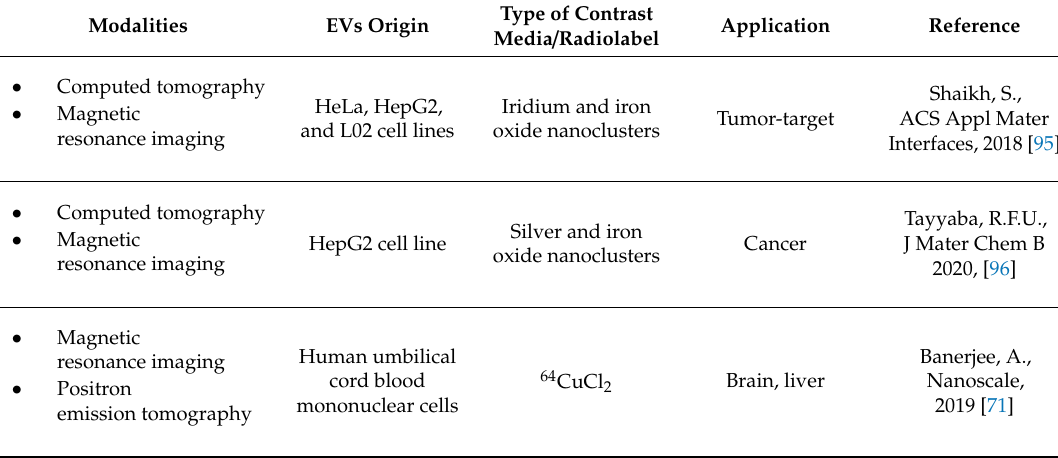
Table 3. Studies on multimodal imaging of